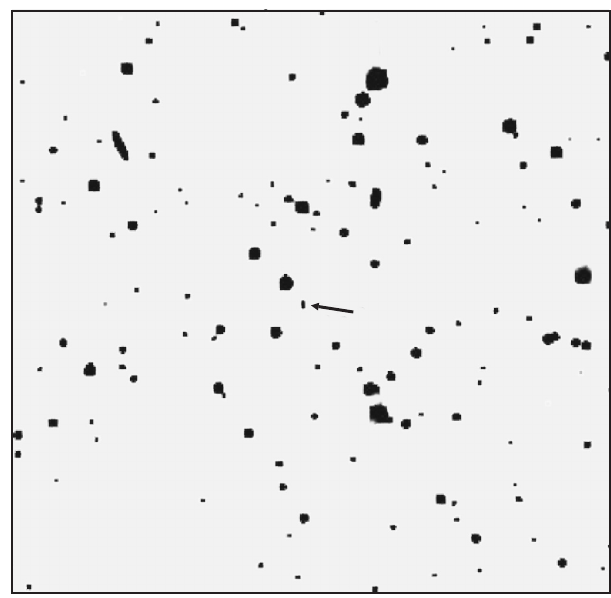
Fig. 1. One of the discovery images of the asteroid 2010 BT3 at RA = 08:36:15.83, DEC = +25:04:05.3 (J2000). The size of the image is 15 ′ (cid:2) 15 ′ , the exposure time is 6 min. Taken with the Maksutov telescope on 2010 January